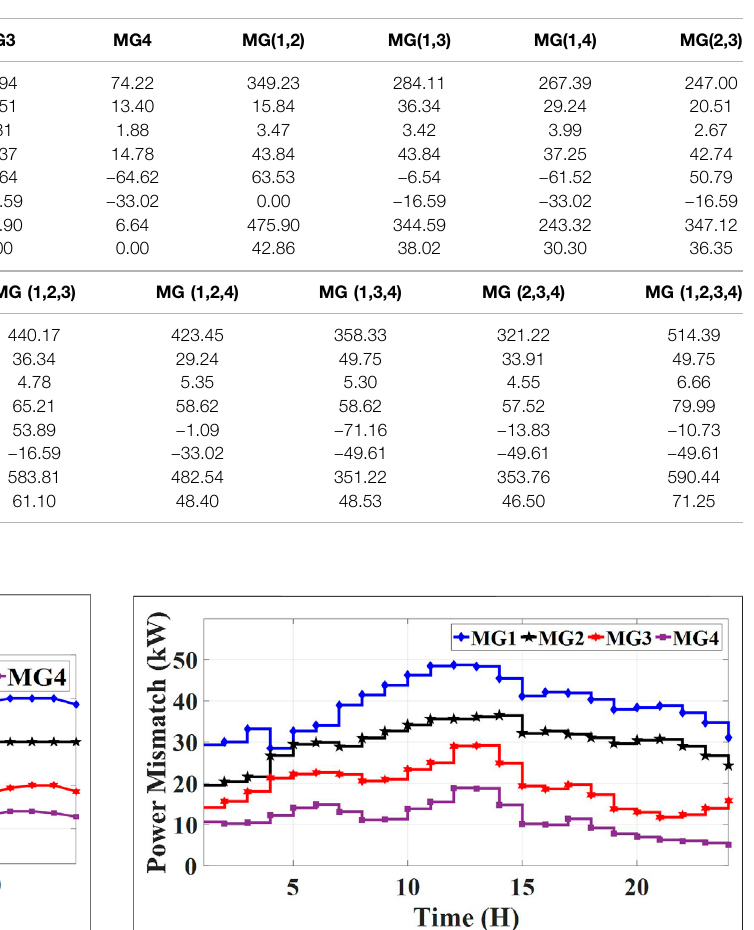
TABLE 2 | Operational cost and RC for coalitions of MGs.